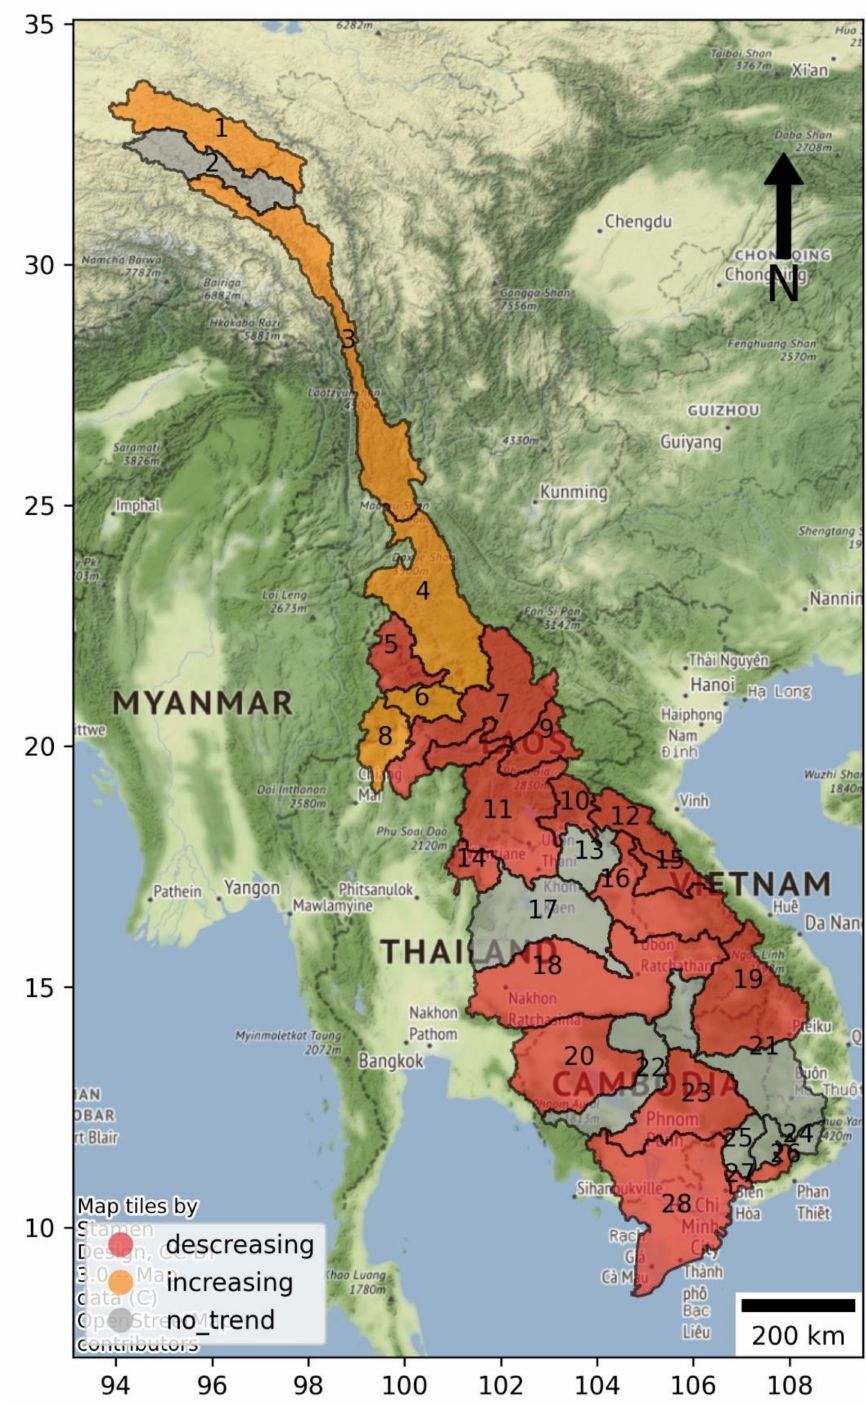
Figure 8. Trend of droughts in the